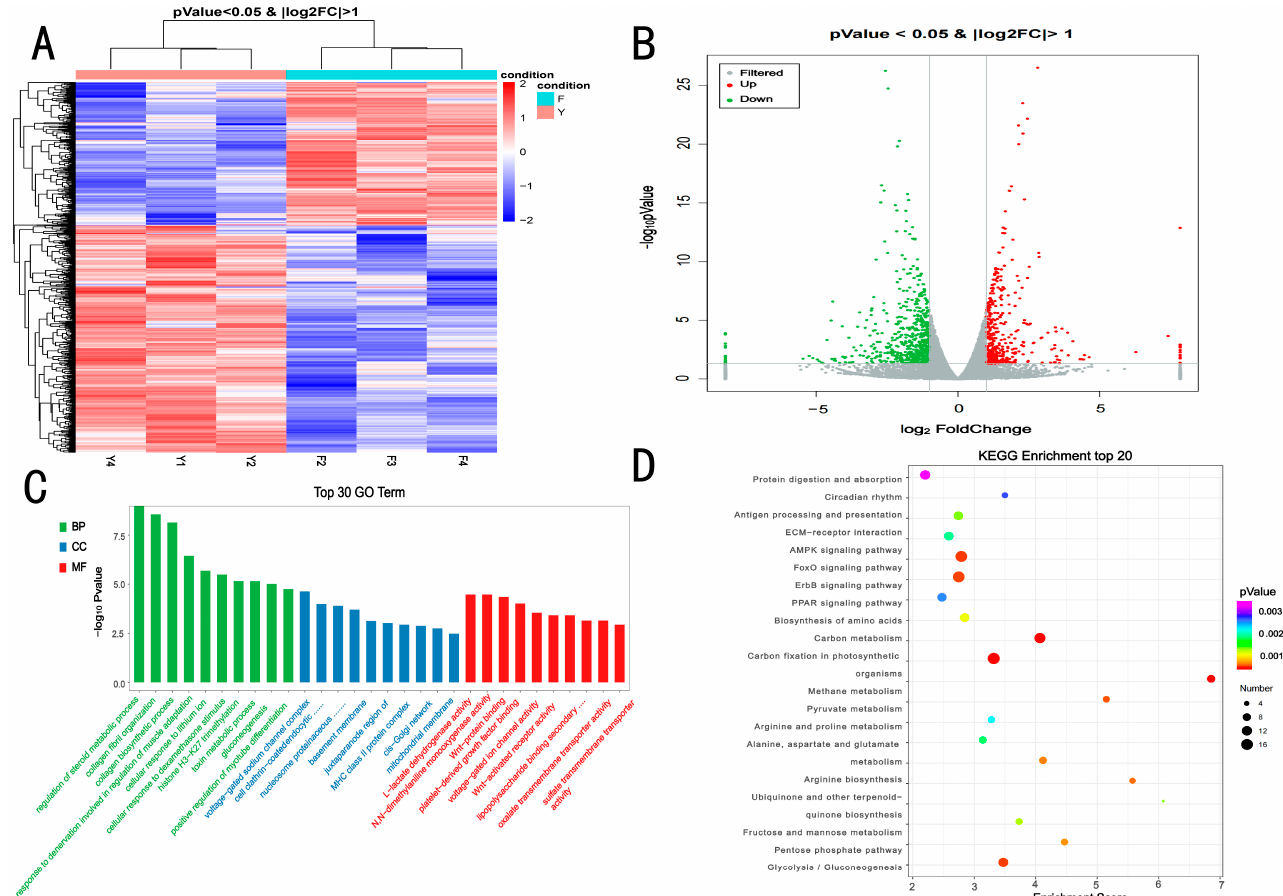
Figure 1. The number of differentially expressed mRNAs in (control/experiment) Group G vs. Group HF comparisons. ( A ) Hierarchical clustering of DEGs, ( B ) Volcano plot of DEGs, ( C ) GO term enrichment for DEGs in the Group G vs. Group HF comparisons, ( D ) KEGG term enrichment for DEGs in the Group G vs. Group HF comparisons.